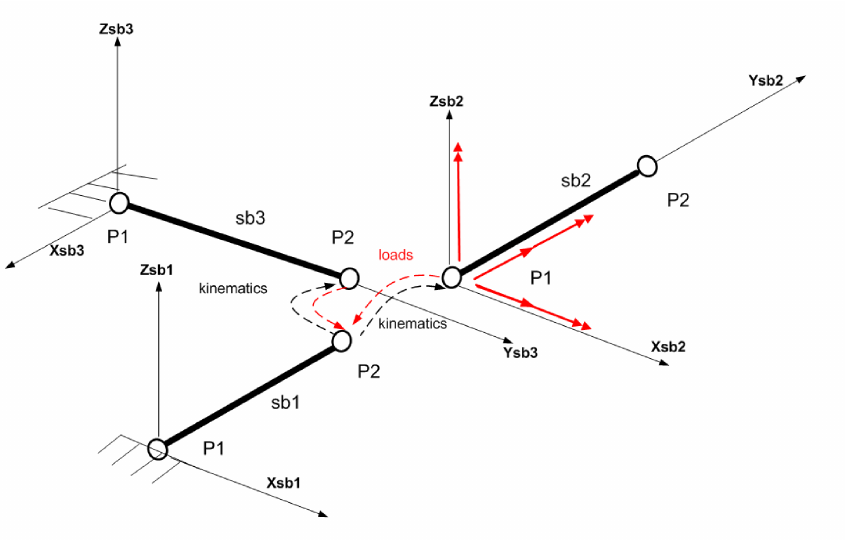
Figure 1. Compatibility conditions. Example between 3 sub-bodies (sb1, sb2,